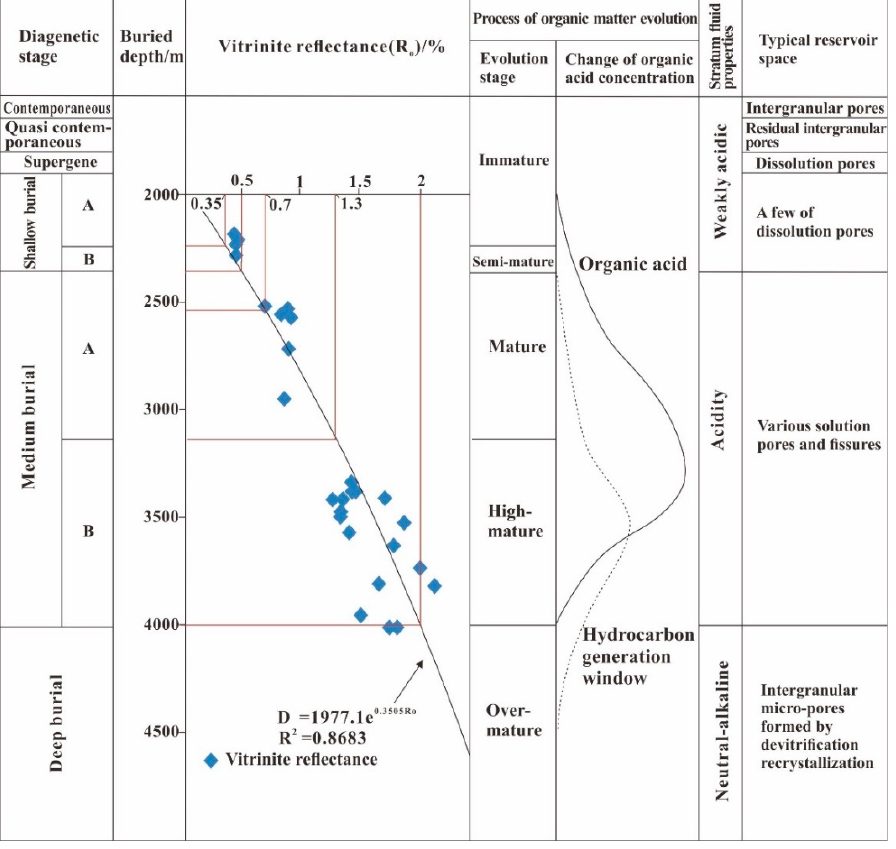
Figure 8. Diagenesis stage of sedimentary pyroclastic rocks in K 1 y 2 , YFD (the data of R o from Jilin Oilfield).